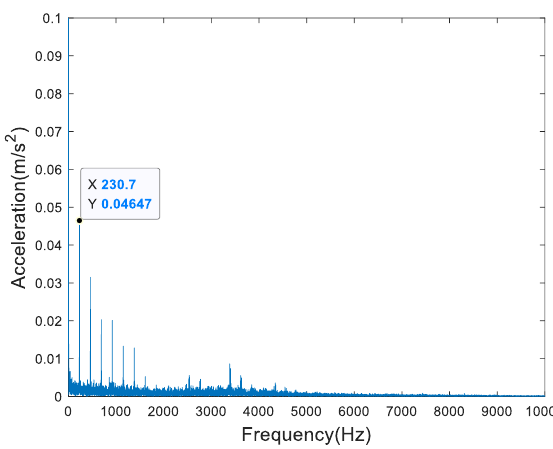
Figure 6. The frequency spectrum of the 700th group of Bearing2-1IMS demodulated by HT.